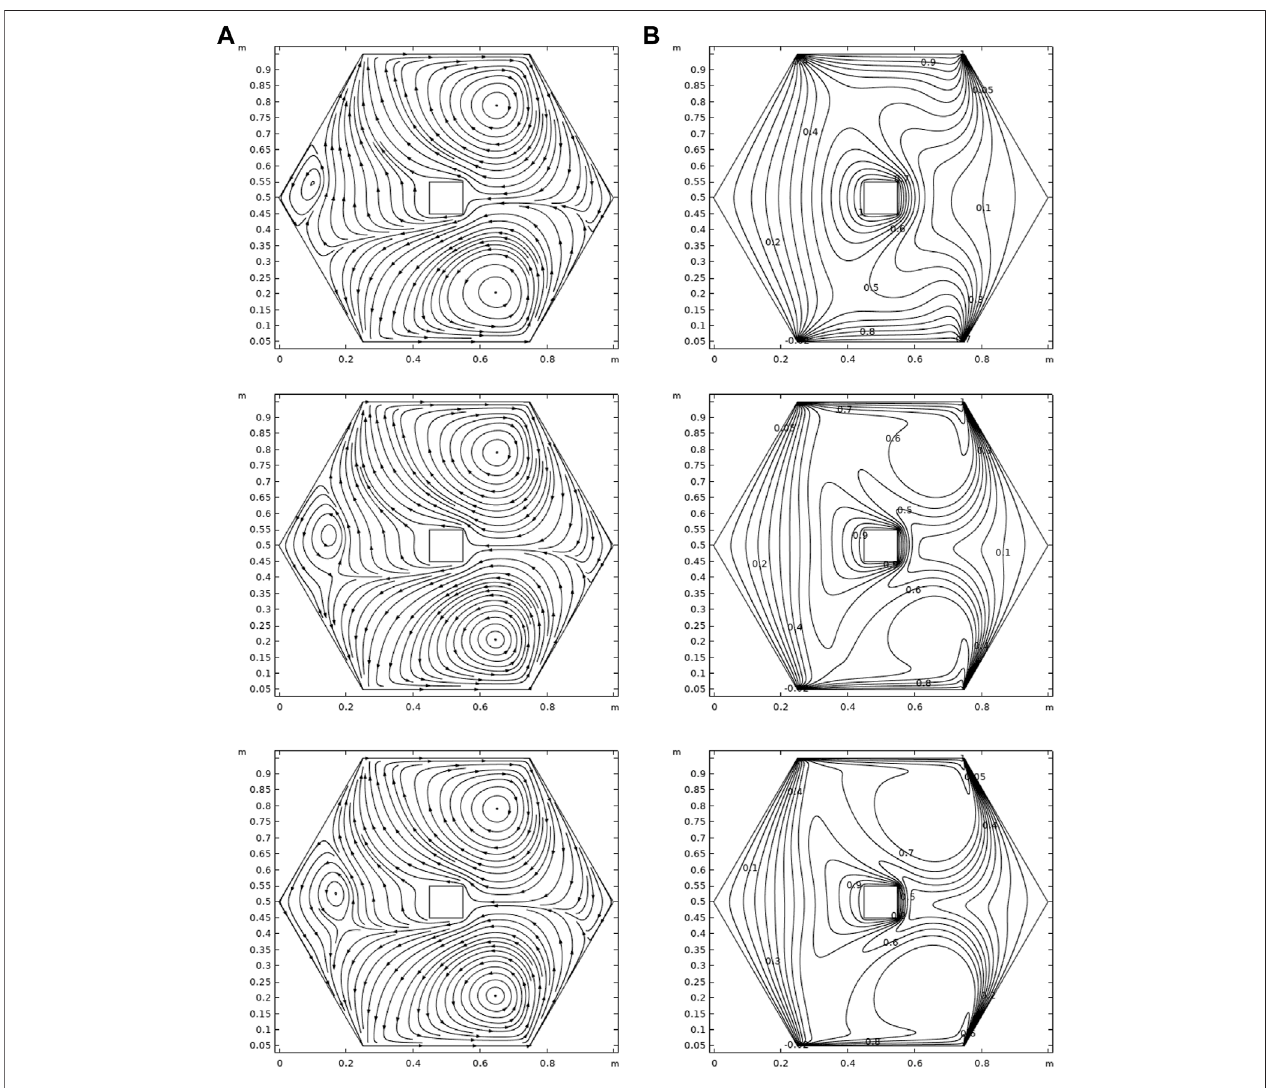
FIGURE 4 | In fl uence on streamline (A) and isotherm (B) with different Pr with n (cid:2) 0 . 5 , Gr (cid:2) 1000, and Re (cid:2) 200 .